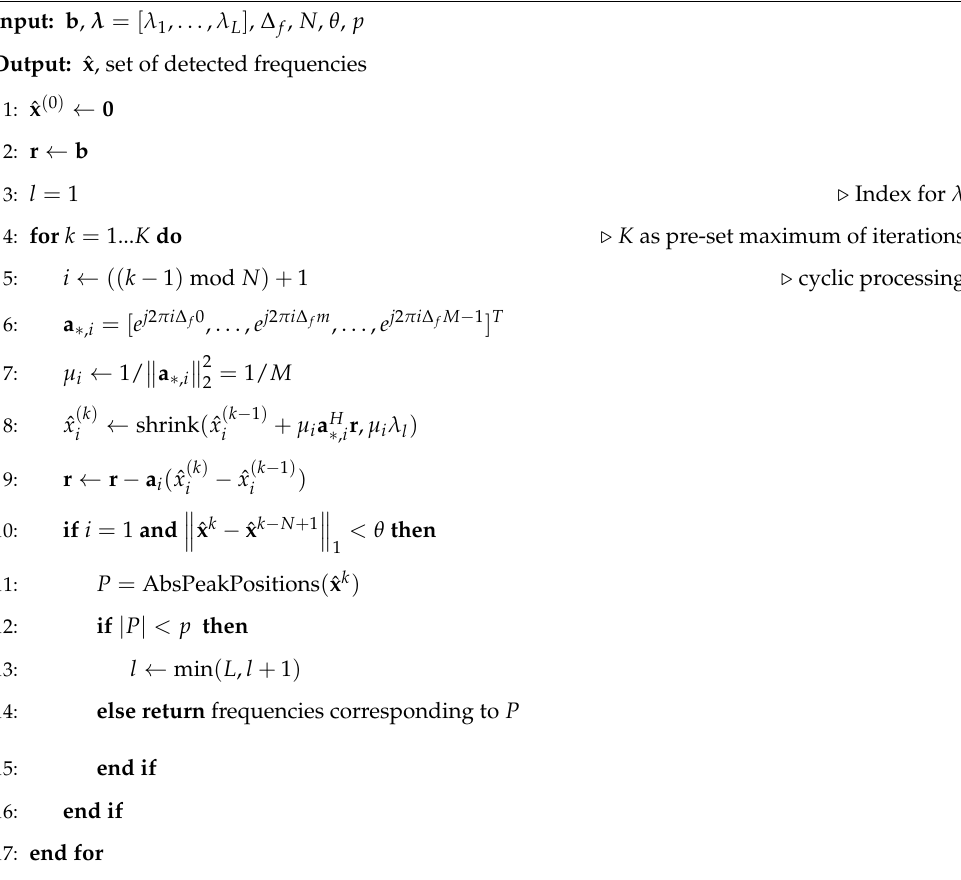
Algorithm 1 Sparse cyclic coordinate descent (SCCD) for frequency estimation